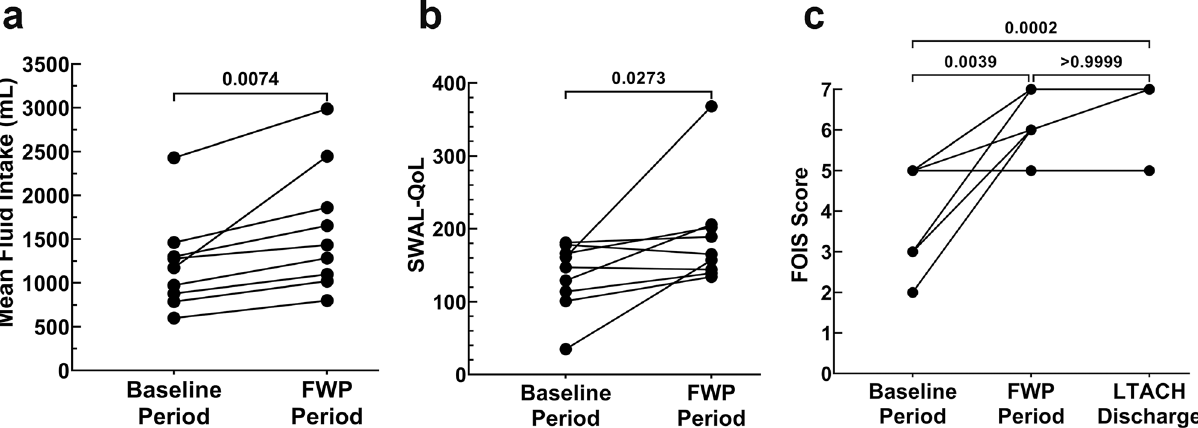
Figure 2. Participant outcomes. ( A ) The mean fluid intake was recorded for the Baseline period, days 1–3, and for the FWP period, days 5–7; mean fluid intake for each period is shown. Baseline fluid intake consisted of orally delivered thickened liquids and any enteral delivered liquids. FWP consisted of oral thickened liquids, enteral liquids, and oral thin liquid water. ( B and C ) Participant quality of life related to swallowing ( B ) and swallowing function via FOIS ( C ) were assessed just prior to the start of the Baseline period and again when participant’s discharged from the FWP; FOIS was recorded a final time upon LTACH discharge. Before and after plots were used to visualize the progression of scores between time points; n = 9. FOIS—functional oral- intake scale; FWP—free water protocol; LTACH—long term acute care hospital; mL—milliliter; SWAL-QOL— swallowing related quality of